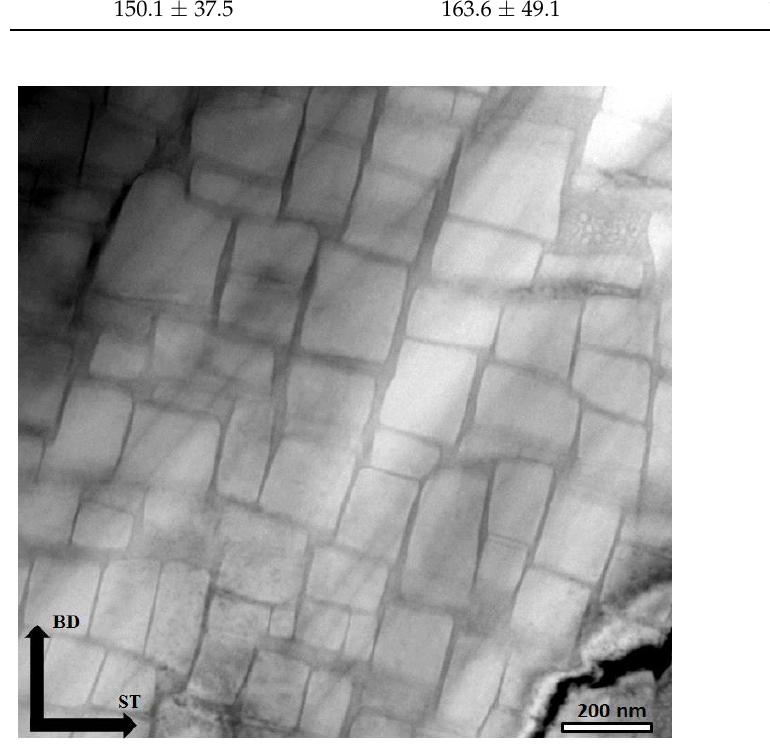
Figure 10. Secondary γ′ -phase precipitations in the repaired region.